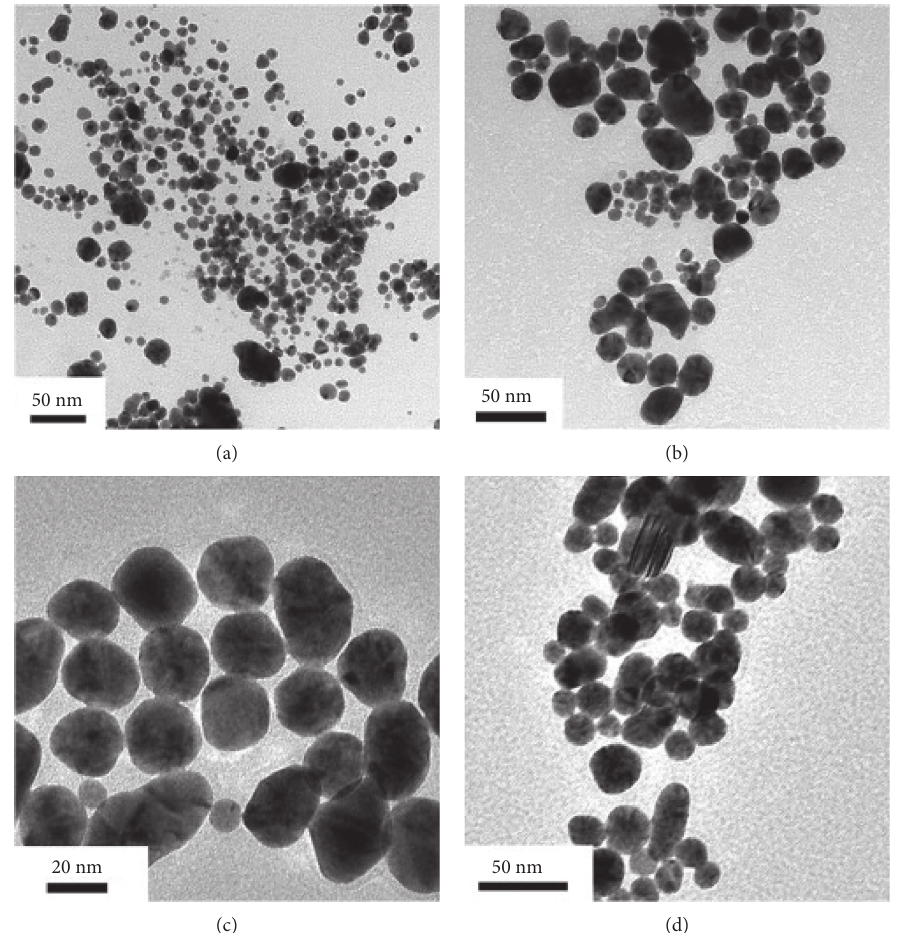
Figure 8: TEM images of the Au NPs synthesized by sonoelectrochemical method at different pulse times ( τ (b) 0.4 s/0.4 s. (c) 0.5 s/0.5 s. (d) 1.0 s/1.0 s. Reproduced from [44] under the terms of the Creative Commons CC BY